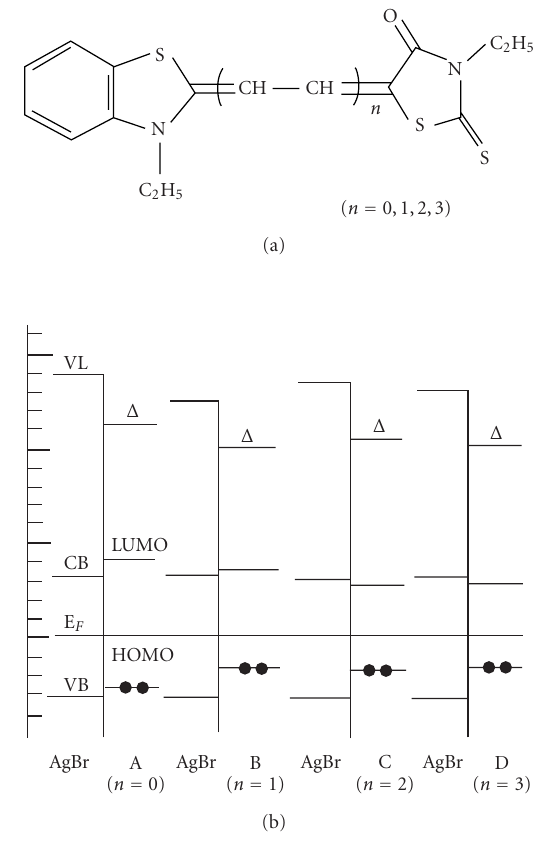
Figure 10: The electronic structure of the interfaces between me- rocyanine dyes having di ff erent chain lengths and silver bromide as determined by UPS measurement, where VL, E F , CB, and VB are the vacuum level, Fermi level, conduction band, and valence band, respectively, LUMO and HOMO are the lowest unoccupied and the highest occupied molecular orbitals, respectively, and Δ is the dis- placement of the vacuum level of a dye with respect of the vacuum level of silver